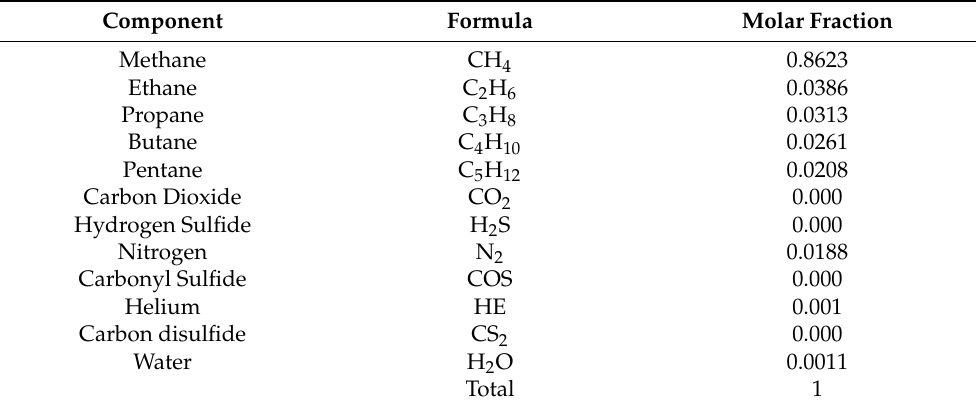
Table 6. VMM basin gas composition after